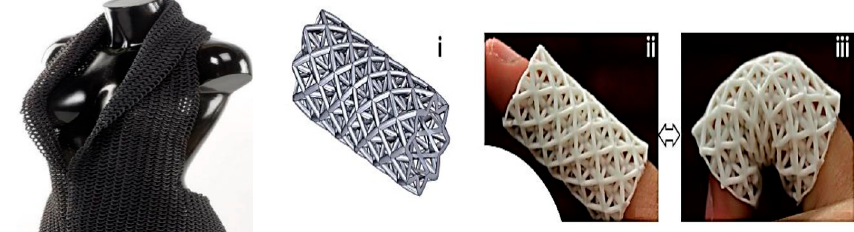
Figure 16. Testing garment fit over real body model ( a ) and the scaled 3D printed body model ( b ) [1].